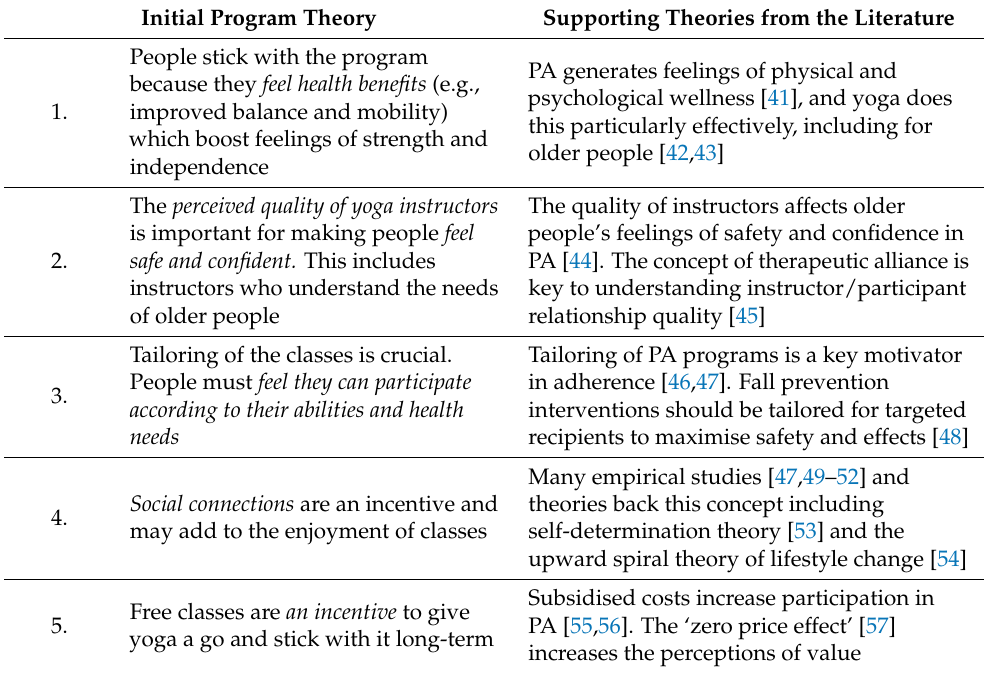
Table 2. Initial program theories about how SAGE works for most